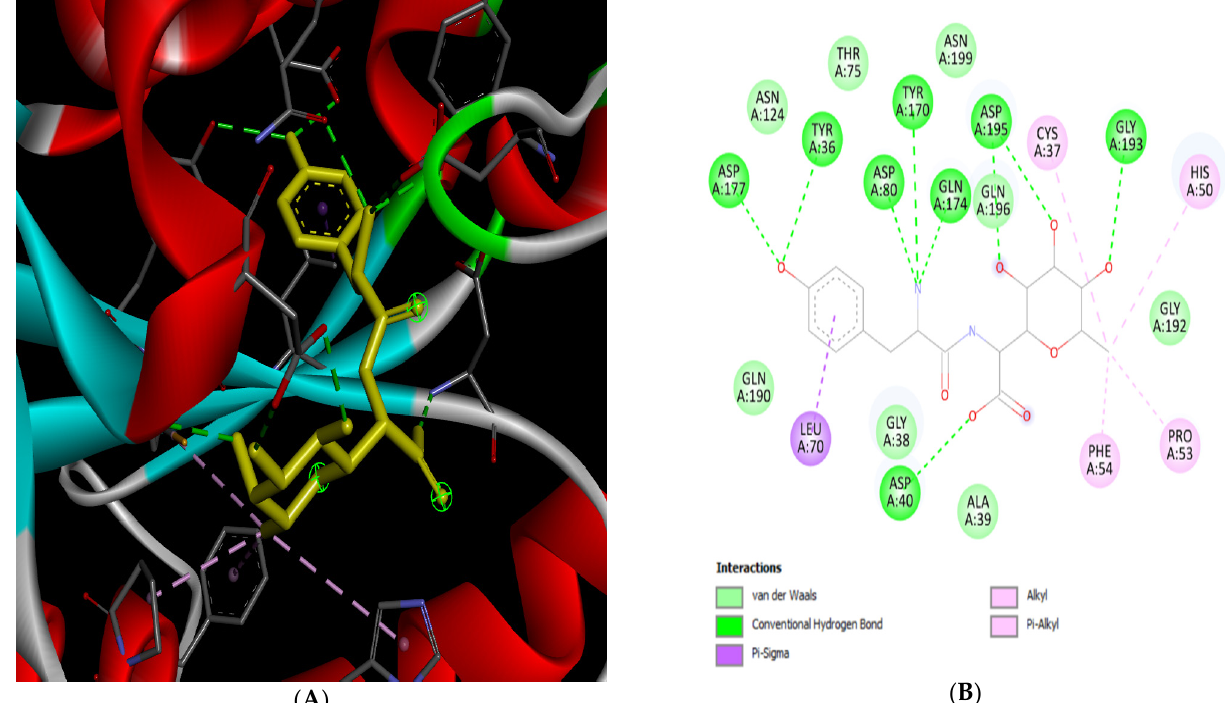
Figure 6. 2D ( B ) and 3D ( A ) representation of TyrRS docked with its cocrystalized inhibitor. Molecules 2021 , 26 , x FOR PEER REVIEW